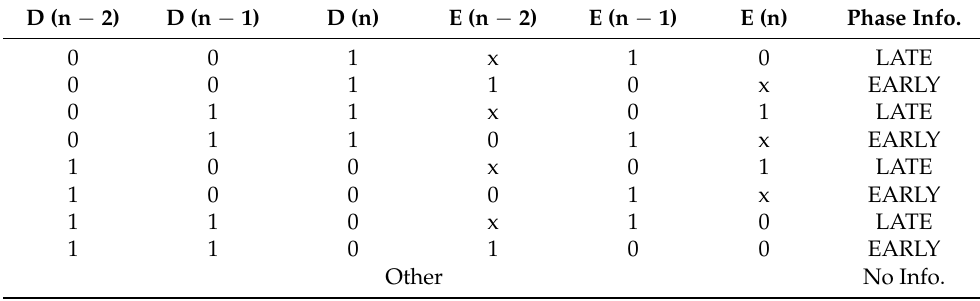
Table 1. Truth table of